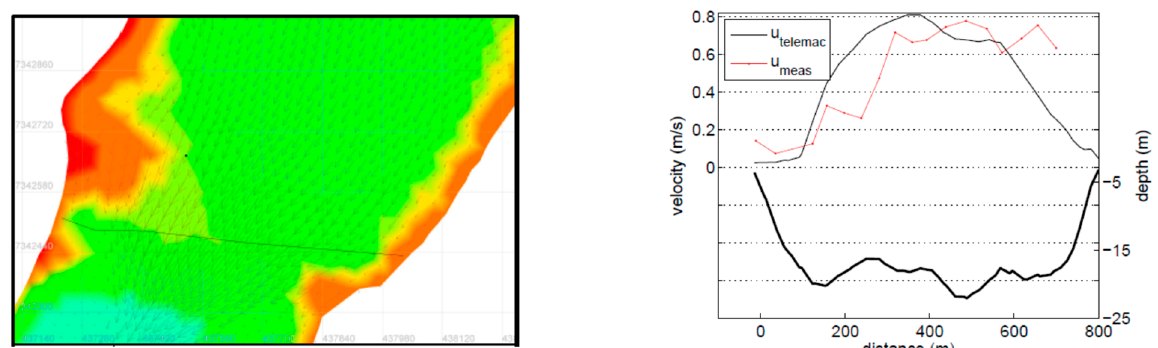
Figure 10. Cross-sectional measurements during incoming tide with the depth line along the transect highlighted [31].